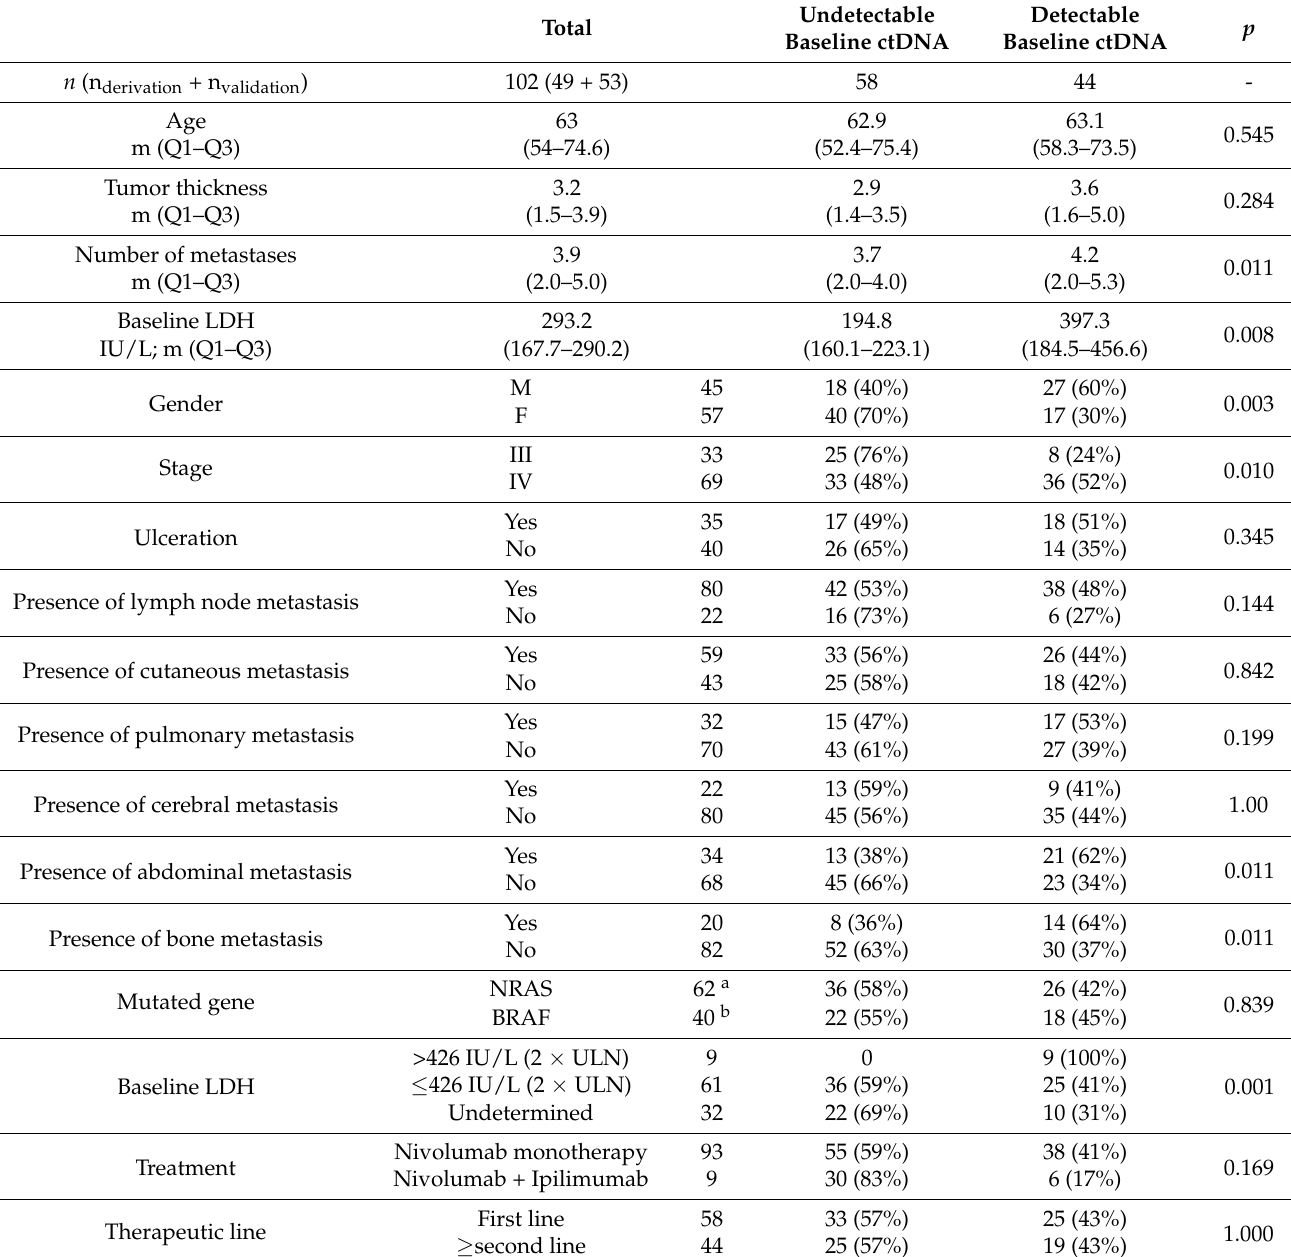
Table 3. Patient characteristics in pooled